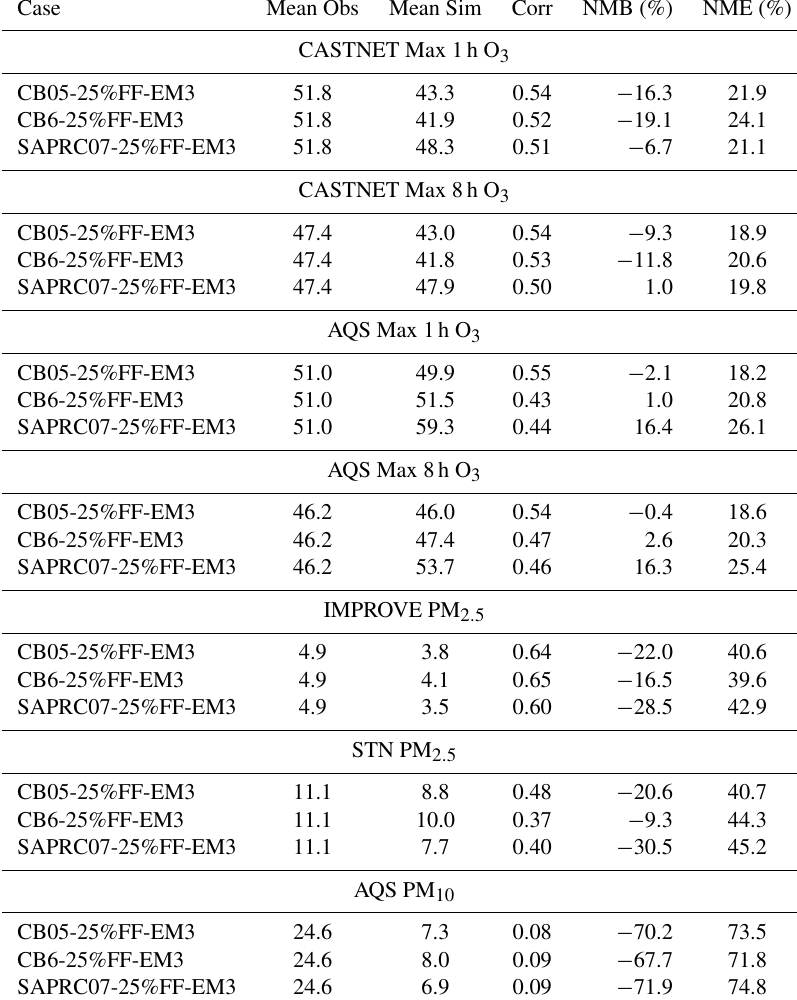
Table 7. Statistics for max 1h and max 8h O 3 for simulations with different gas phases against CASTNET and AQS for May to June 2010.